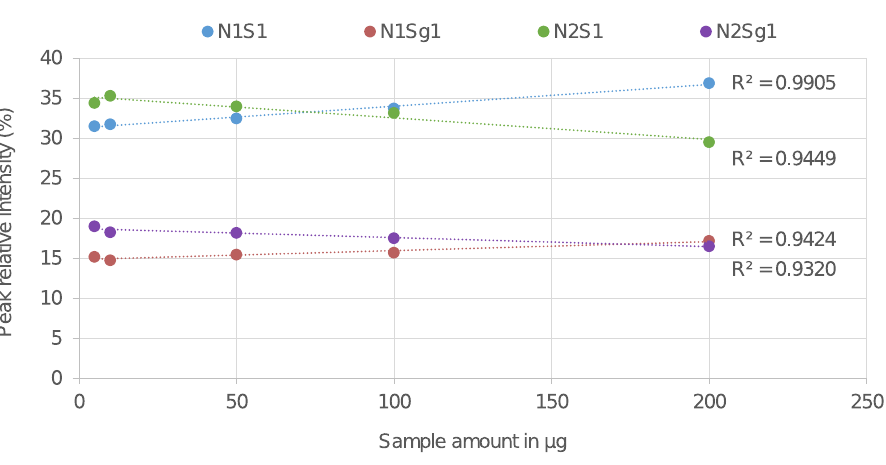
Fig 3. Triplicate samples of BSM type I-S glycoprotein from different starting material amounts (200 μ g, 100 μ g, 50 μ g, 10 μ g and 5 μ g) released, purified and permethylated using the liquid handling robot. Relative peak intensities, extracted after MALDI-TOF-MS analysis, were plotted for four major O -glycan peaks. A visual evaluation of the analyte signals as function of the concentrations is shown in this linear regression plot to assess linearity as a validation